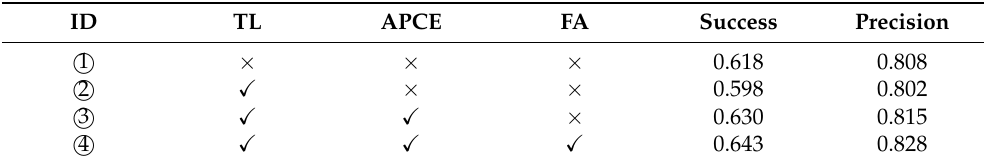
Table 2. Ablation study of the proposed tracker on UAV123. We compared the performance of partial module deactivation, (cid:88) and × represent module in use or not,